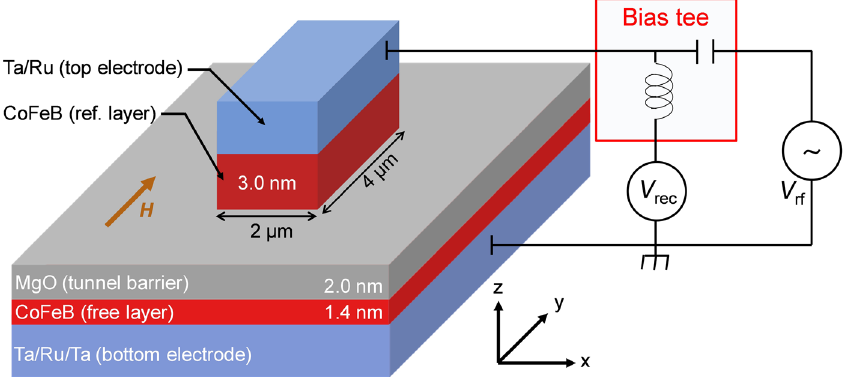
Figure 1. Schematic diagram of device and experimental set up. RF signals are sent through capacitor port of bias tee and rectified voltages are measured through dc port of bias